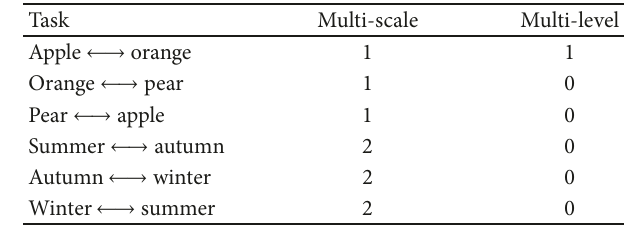
Table 3: Multiscale and multilevel parameters in the different